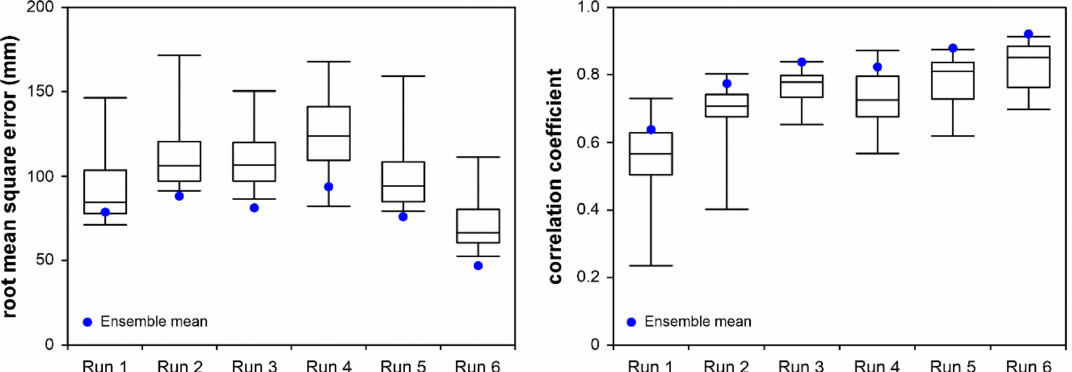
Figure 6. Performance of the ensemble rainfall forecasts (box-and-whisker plot) of TTFRI-EPS and the conventional ensemble mean (blue dot) during typhoon